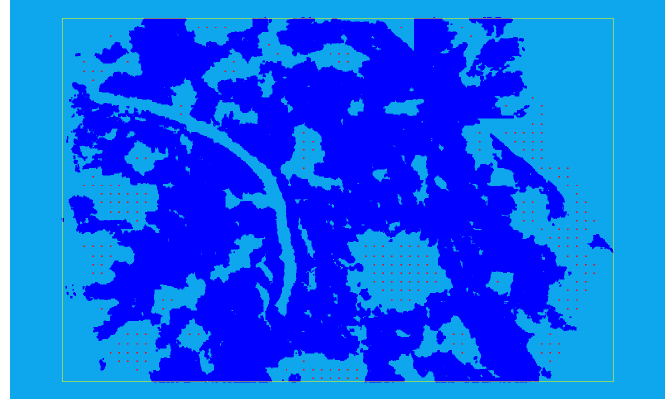
Figure 12. Added points (red) in the cloud for a distance of 5 m.